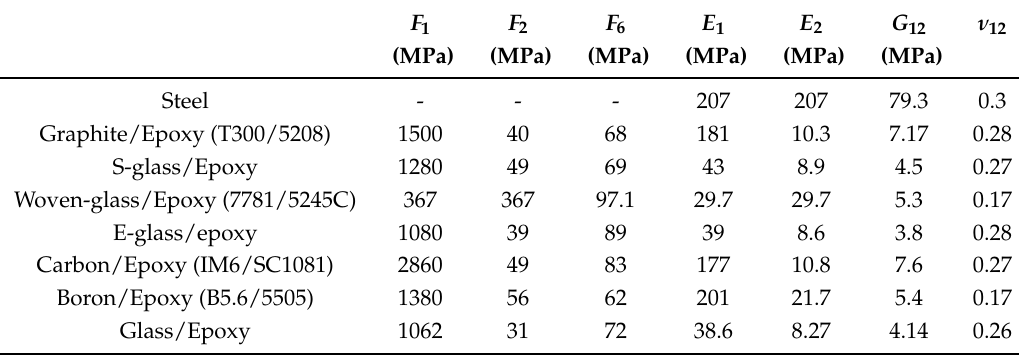
Table 3. Material properties of the plate by Daniel and Ishai